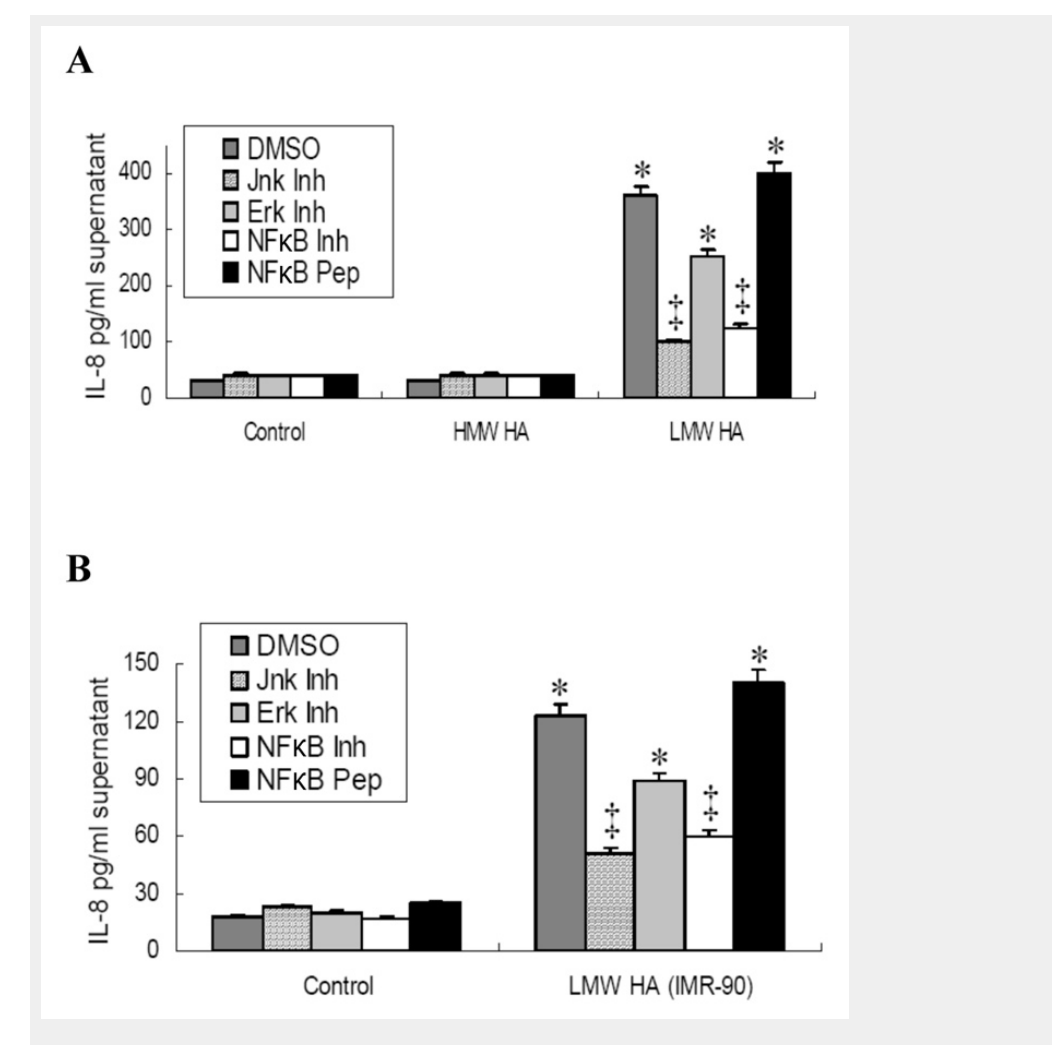
Figure 4 Inhibition of JNK and NF-κB, but not ERK, blocked LMW-HA induced IL-8 production in human BEAS-2B bronchial epithelial. BEAS-2B cells were pre-incubated with inhibitors of JNK, ERK, and NF-κB or with an NF-κB control peptide for one hour before HA stimulation. BEAS-2B cells were then exposed to LMW-HA, HMW HA, or no HA with carrier DMSO in serum free medium for 6 hours. A. LMW-HA from bovine vitreous humor and HMW HA from rooster comb (n = 5); B. LMW-HA isolated from IMR-90 fibroblast HA (n = 3). * p <0.05 vs controls; HMW HA; LMW-HA+JNK inhibitor and LMW-HA+NF-κB inhibitor. ‡ p <0.05 vs. LMW-HA+DMSO; LMW-HA+ERK inhibitor and LMW+NF-κB control